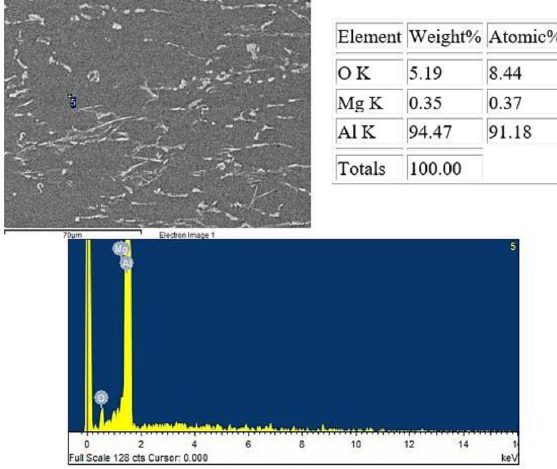
Figure 3: Point scan SEM-EDS analysis of grain centre of Al 6063/6 wt.% steel p